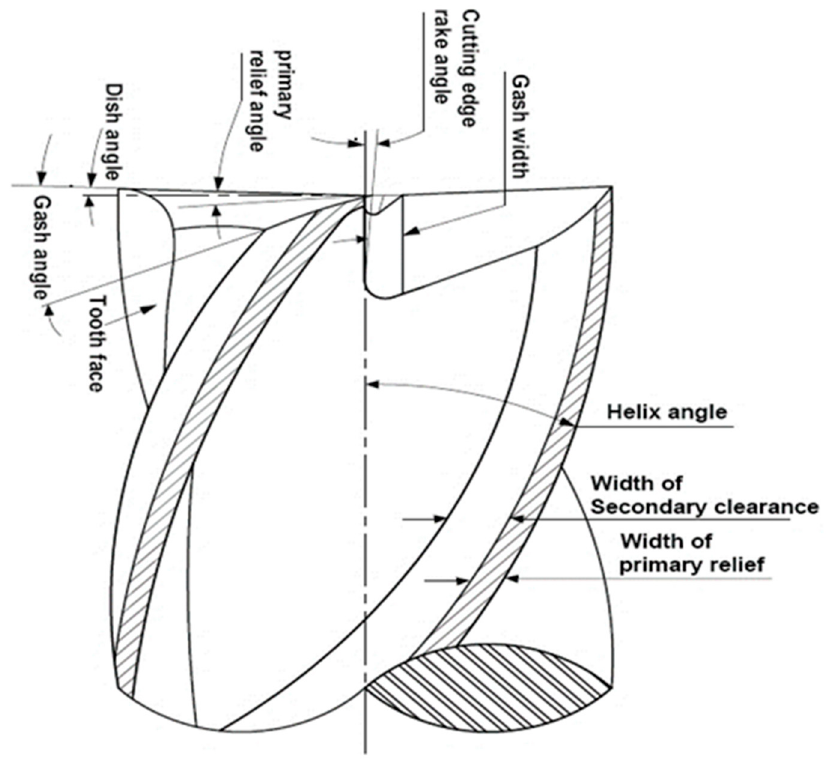
Figure 1. Geometrical parameters of an end mill.